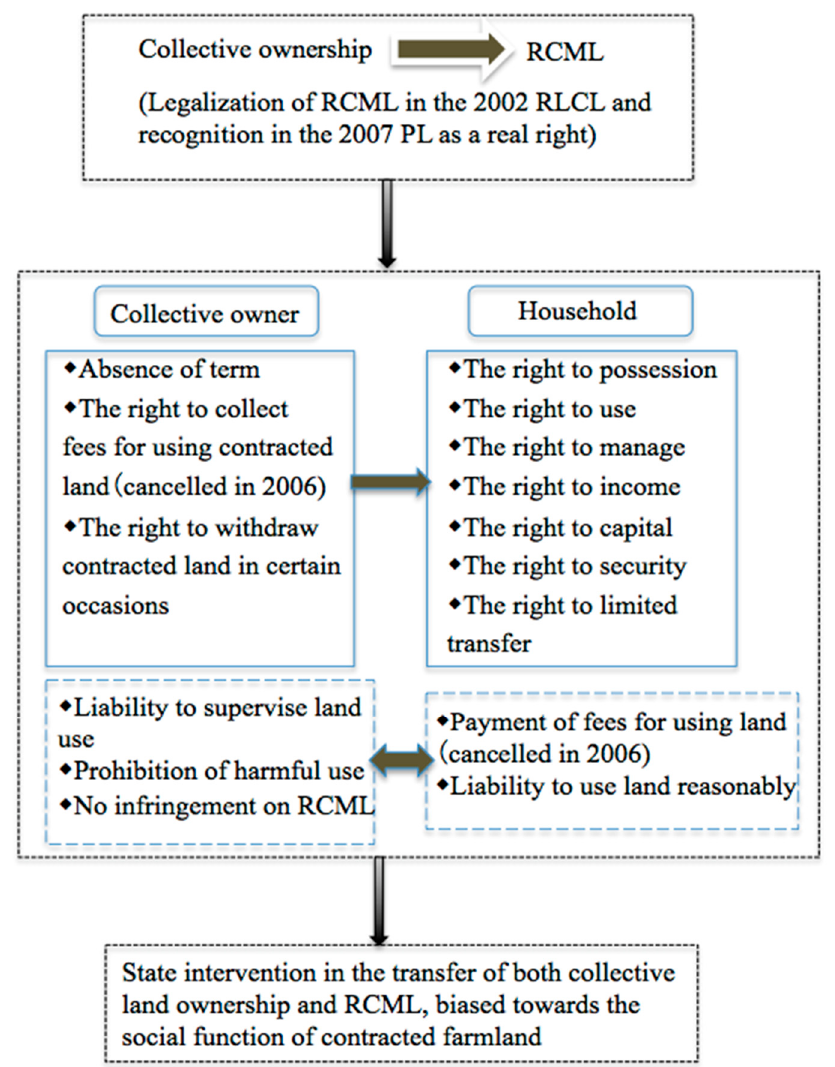
Figure 3. A three-step analysis of the bifurcation of rights on contracted farmland.